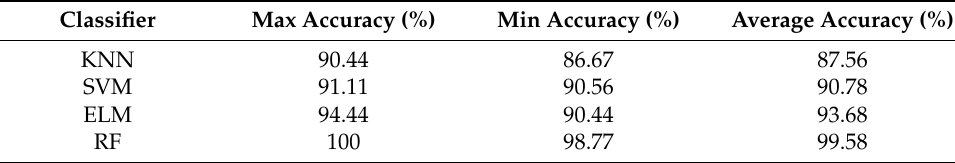
Table 3. Identification accuracies of pipe condition with various classifiers.